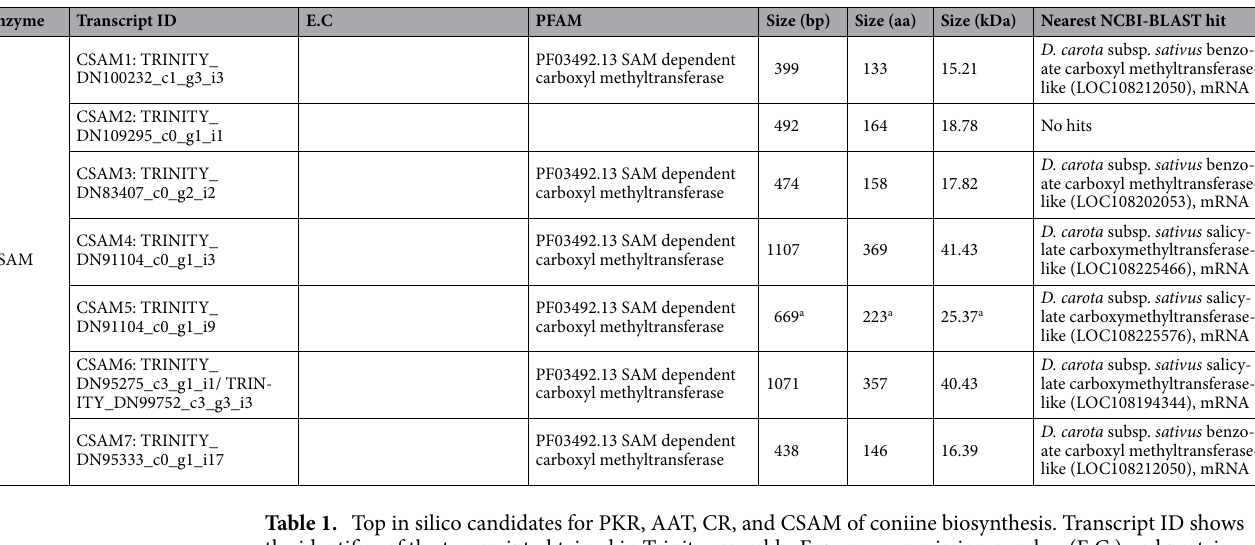
The bacterial gene involved in Koreenceine synthesis Function predicted by Lozano et al. 20